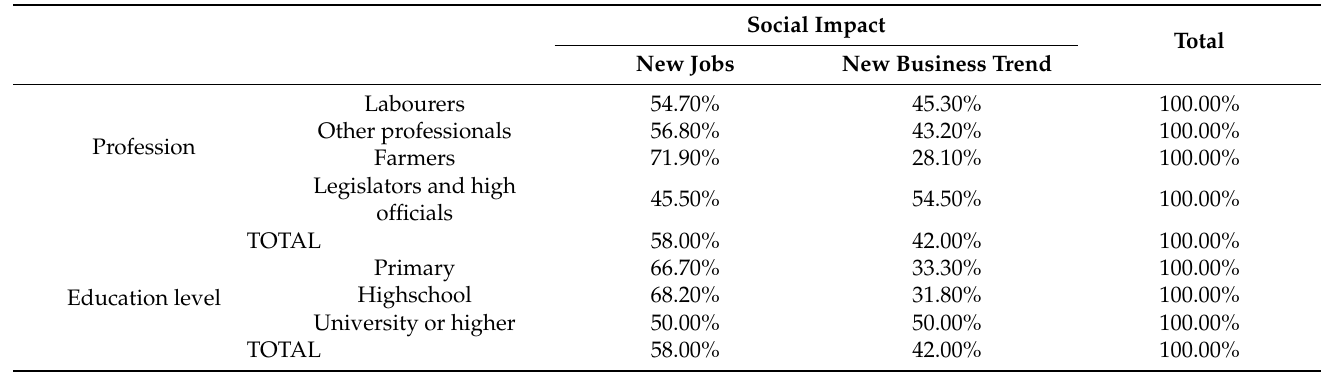
Table 9. Social impact according to education level and occupation.